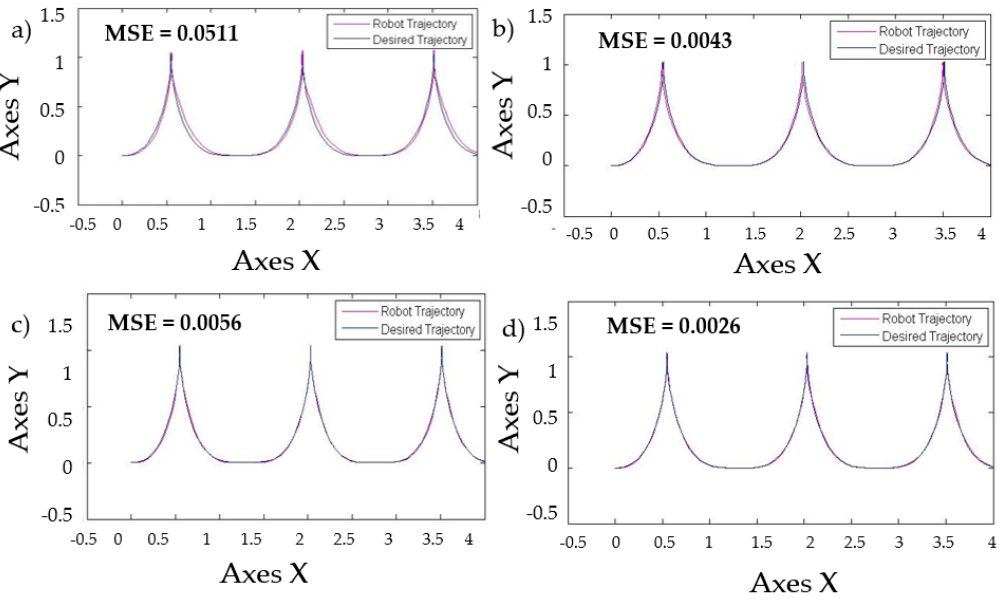
Figure 23. Behavior of trajectory for each method applying perturbation in the model. ( a ) Traditional BCO; ( b ) Fuzzy BCO with Type-1 FLS; ( c ) Fuzzy BCO with IT2FLS; and ( d ) Fuzzy BCO with GT2FLS.